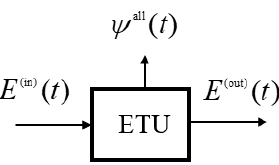
Figure 1. General model of energy transmission unit (ETU).